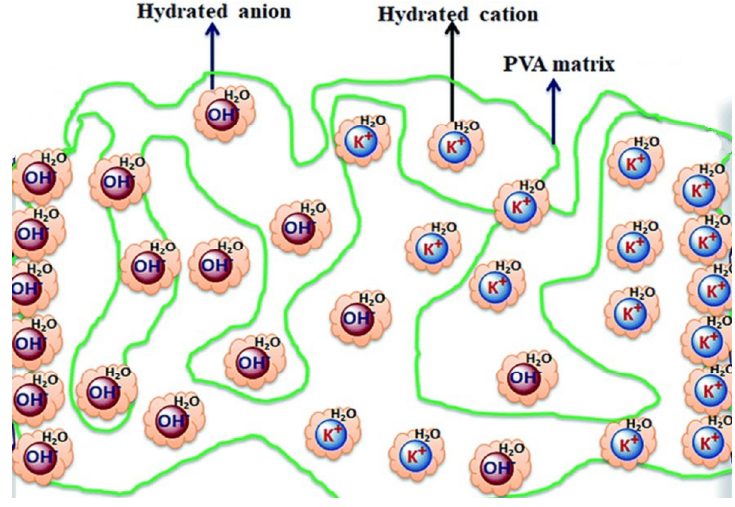
Figure 24. Graphical representation of the hydrogel polymer electrolyte (PVA/KOH/H 2 O) [161].